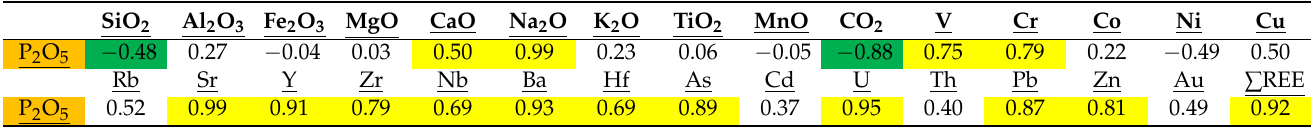
Table 2. Correlation relationships with major oxides and trace elements of P 2 O 5 in phosphate samples (Negative correlations are green color, positive correlations are yellow